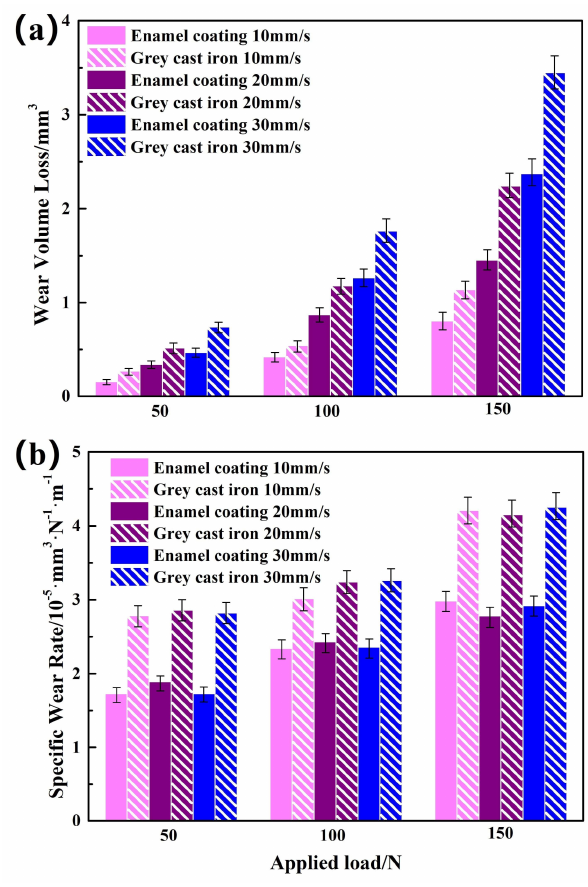
Figure 12. Wear volume loss ( a ) and the specific wear rate ( b ) of the enamel coating and grey cast